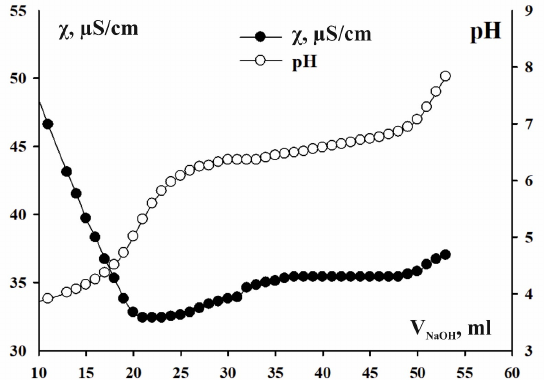
Figure 4. Specific electrical conductivity of the Sm(NO) 3 solution and pH as a function of the NaOH solution volume in the course of conductometric titration .